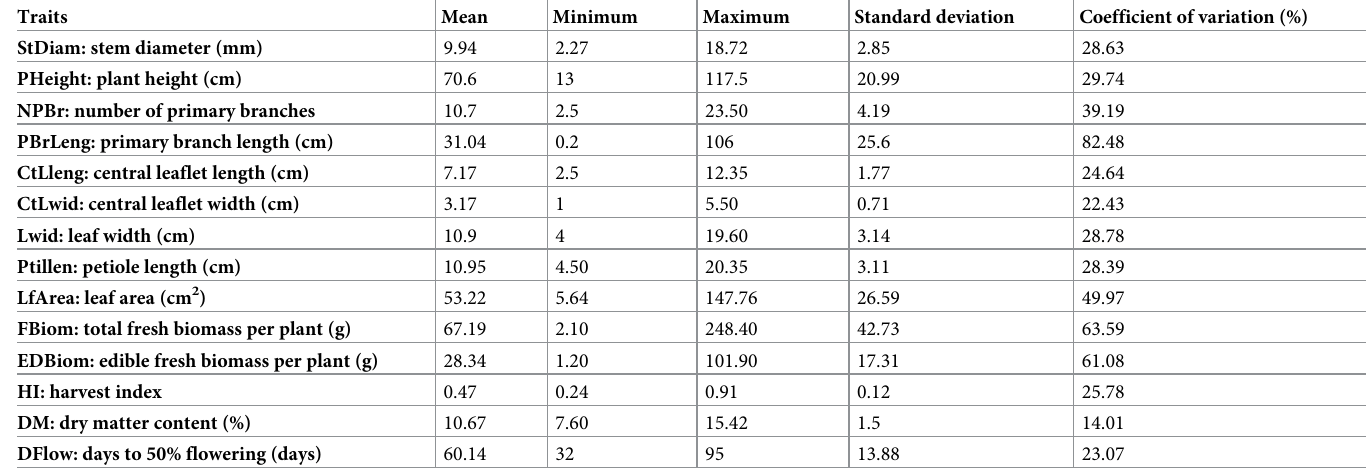
Table 2. Descriptive statistics of biomass and related traits investigated in 71 advanced lines of Gynandropsis gynandra .